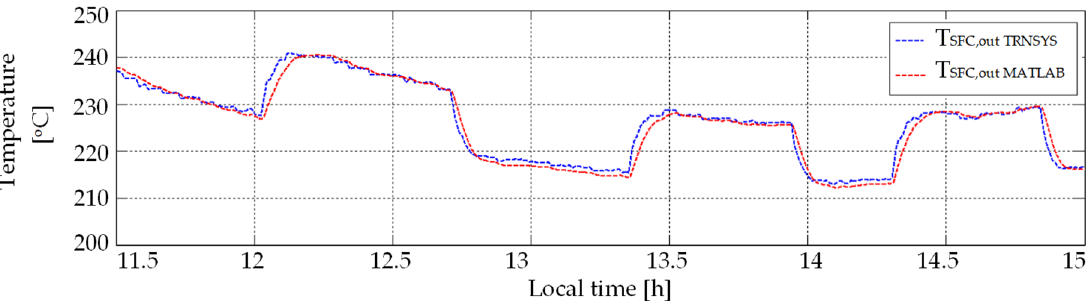
Figure 5. Solar field model validation.